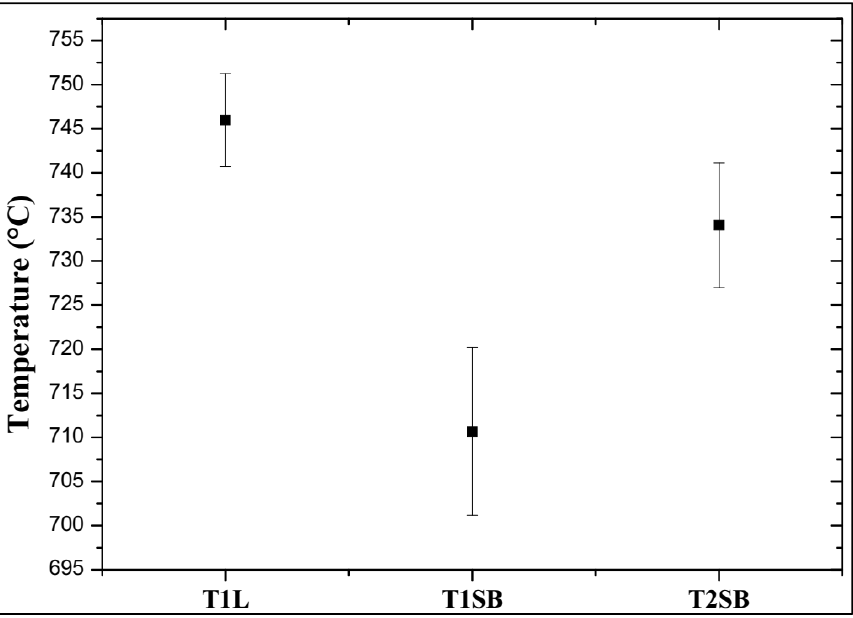
Figure 14. Average temperatures within the red isotherms during the depositions: T1L (linear); T1SB (switchback with F = 30 mm and B = 20 mm); T2SB (switchback with F = 10 mm and B = 5 mm).